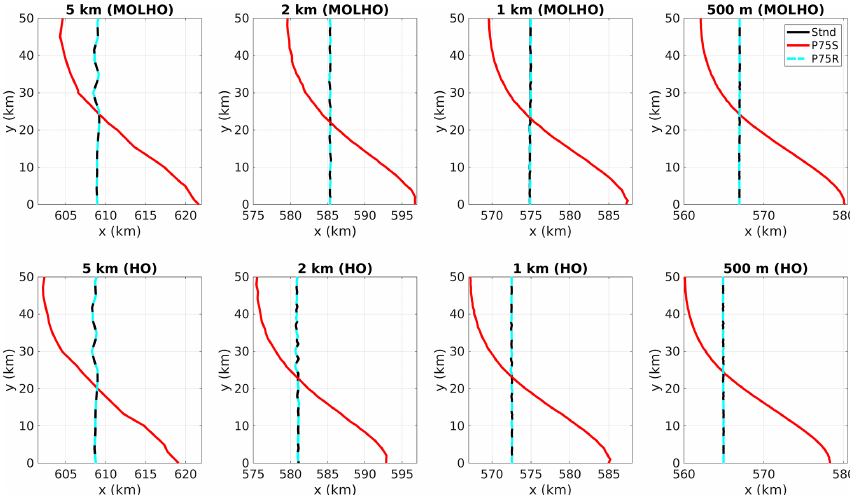
Figure 5. Grounding line positions of the MISMIP3D experiments obtained with different mesh resolutions. Black lines are the steady-state grounding line positions (Stnd). Red lines are the positions obtained after 100 years of basal friction perturbation (P75S). Dashed blue lines are the new steady-state grounding line positions obtained after resetting the friction coefficient to its original value (P75R).